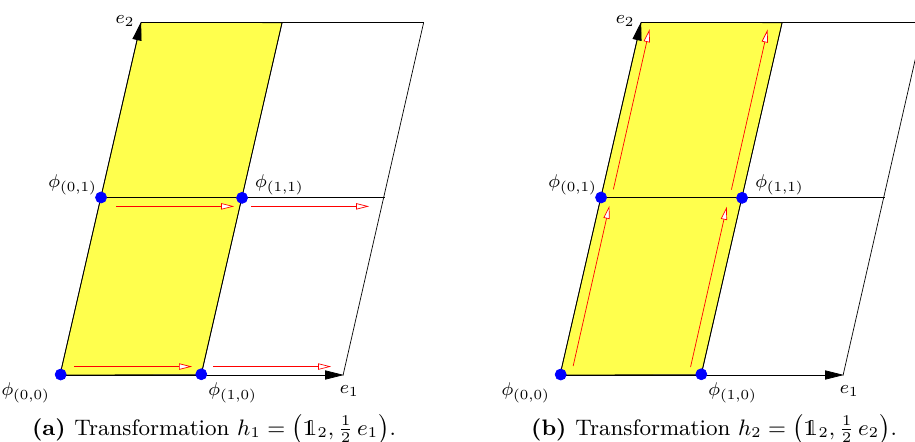
Figure 2 . Actions of the outer automorphisms h 1 and h 2 of the T 2 / Z 2 orbifold space group on the four twisted matter fields ( φ , φ , φ , φ ) . (a) Under the geometrical translation h 1 := (0 , 0) (1 , 0) (0 , 1) (1 , 1) (cid:0) 1 (cid:1) 1 e 1 , matter fields get interchanged as φ ↔ φ for n 2 ∈ { 0 , 1 } . (b) The geometrical 2 , (0 ,n 2 ) (1 ,n 2 ) 2 (cid:0) 1 (cid:1) 1 translation h 2 := e 2 interchanges matter fields as φ ↔ φ for n 1 ∈ { 0 , 1 } 2 , ( n 1 , 0) ( n 1 , 1) 2